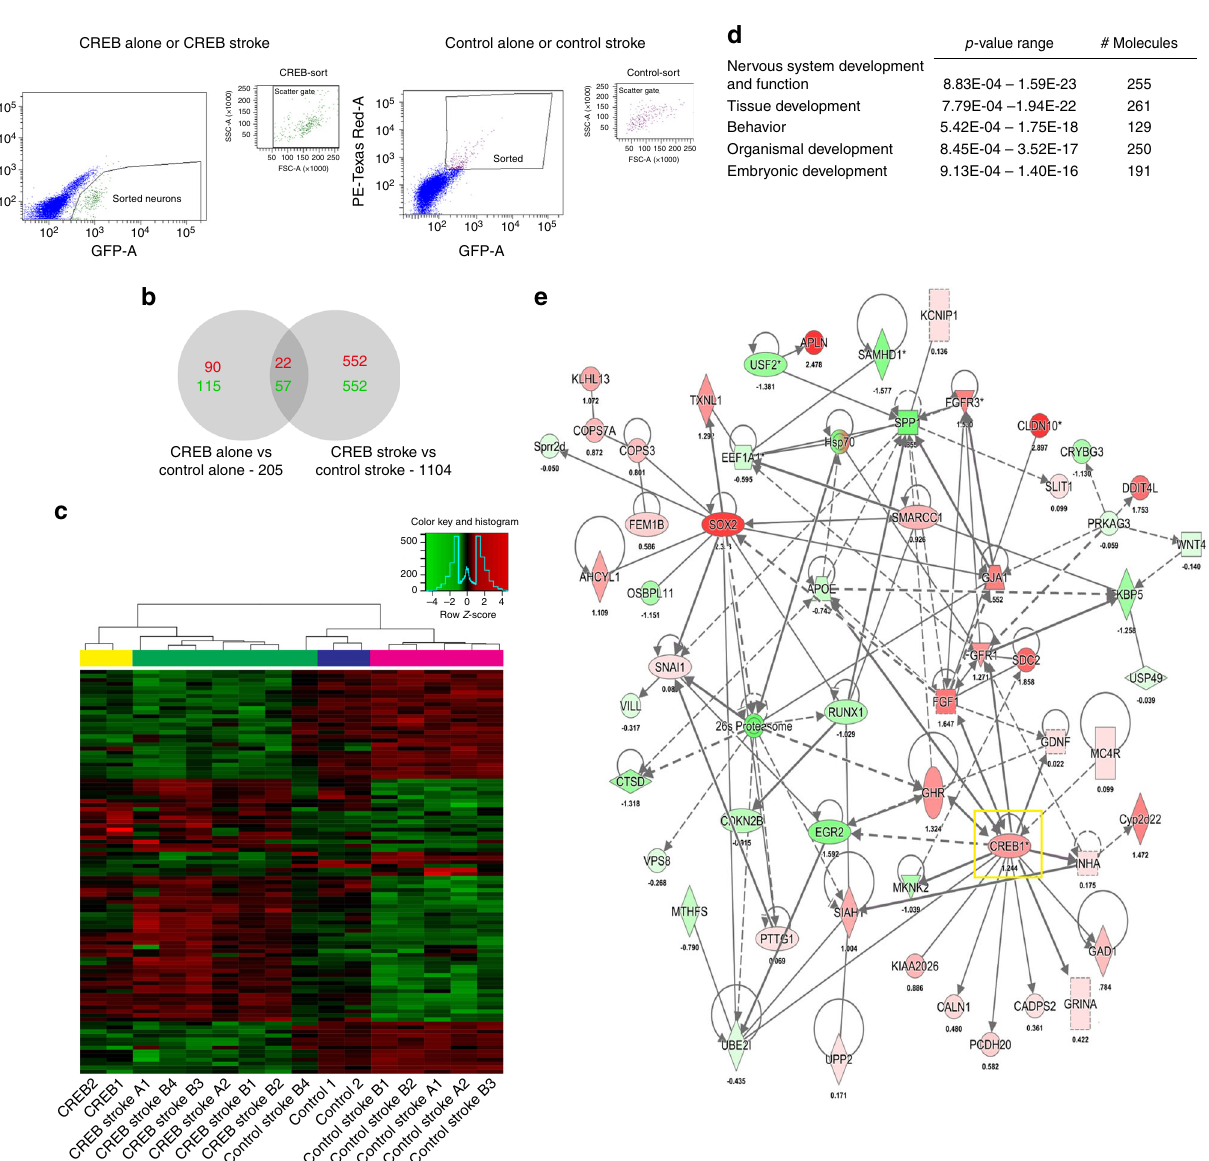
Fig. 7 CREB-stroke transcriptome in motor cortex during period of recovery. a Fluorescence-activated cell sorting (FACS) isolation of CREB-transfected or control neurons in motor cortex after stroke. In the scattergrams, each selected cell is indicated by a dot. The cluster of sorted neurons (cells in the gate) in the scattergram corresponds to neurons that were selected for further analyses of their fl uorescence characteristics. GFP-positive (CREB-transfected) or GFP-/Texas Red-positive cells (control virus, tdtomato-eGFP) with high fl uorescence levels are displayed in a fl uorescence scattergram where FSC (forward scatter light) represents the absorbance of transmitted laser light for each neuron and SSC (side scatter light) the light scattered at a 90-degree angle. b Hypergeometric overlap of genes that are signi fi cantly induced in control motor cortex neurons with CREB transfection compared to normal, non- transfected neurons that overlap with CREB-transfected neurons after stroke compared to non-transfected neurons after stroke. Red: upregulation; green: downregulation. There is little overlap of the two transcriptomes. c Unsupervised clustering of top 100 differentially expressed genes at P < 0.005. Z score is indicated by top right inset. d Top regulated canonical pathways in Stroke + CREB vs Stroke. Middle column shows the inverse log of the P value corrected for multiple comparisons in Benjamini – Hochberg (B – H) test. The left column shows the number of signi fi cantly regulated genes in the Stroke- CREB transcriptome that are within this canonical pathway. e Molecular pathway analysis showing interactions between signi fi cantly regulated genes in the Stroke-CREB transcriptome. Red is upregulated with darker indicating greater fold change. Downregulation is in green with same color strength scheme. Log2 fold change is below each